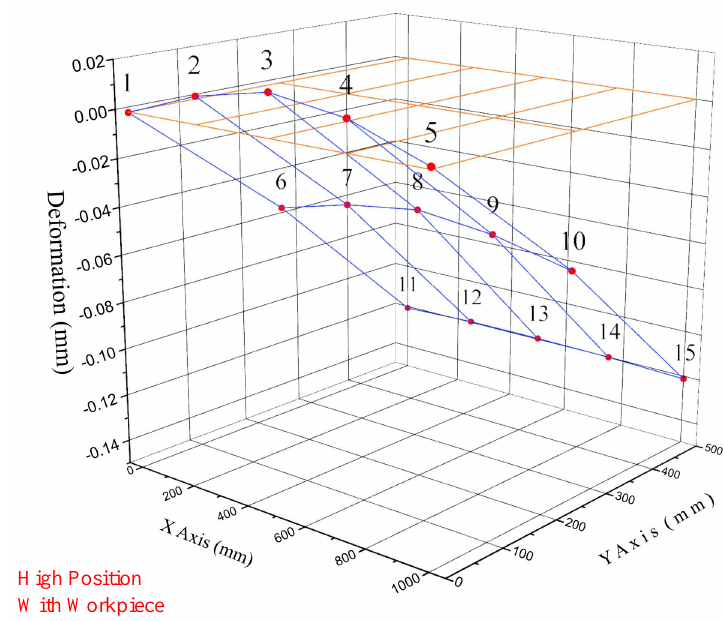
Figure 13. Schematic diagram of the load on the high point of the spindle.